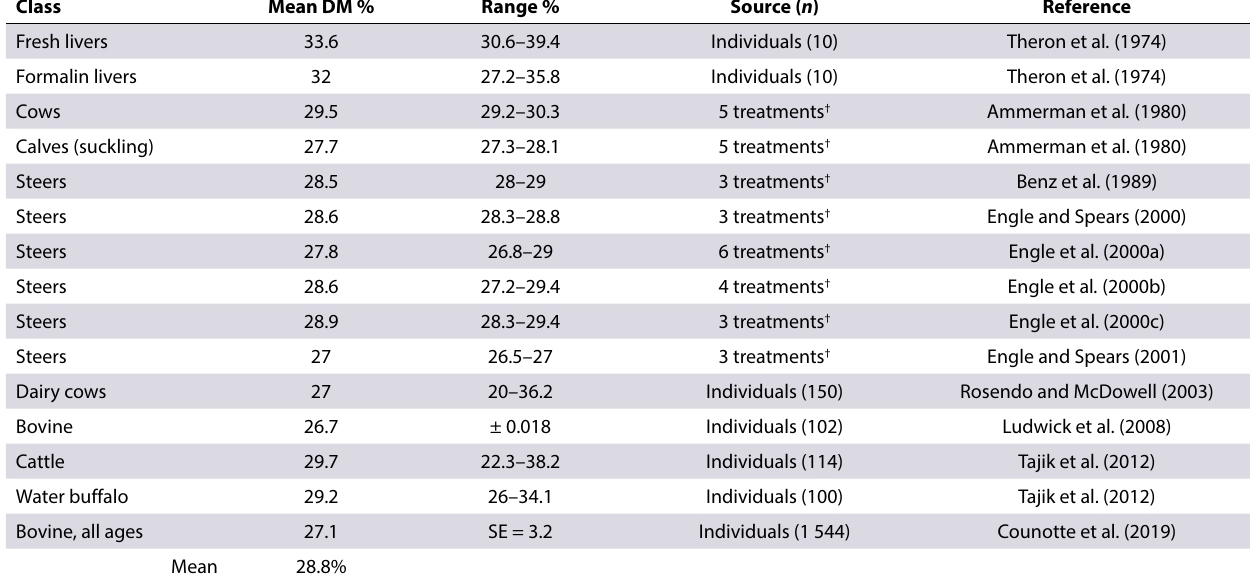
Table I: Percentage dry matter (DM) in the livers of bovine, as reported in the literature